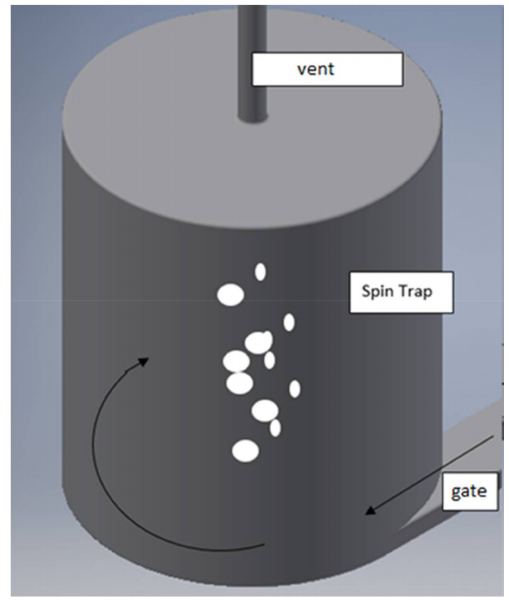
Figure 8. Spin trap